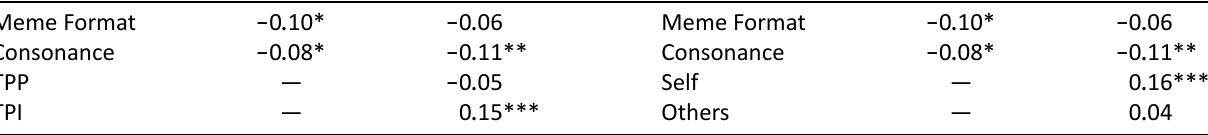
Table 2. Effects of perceptions of influence on